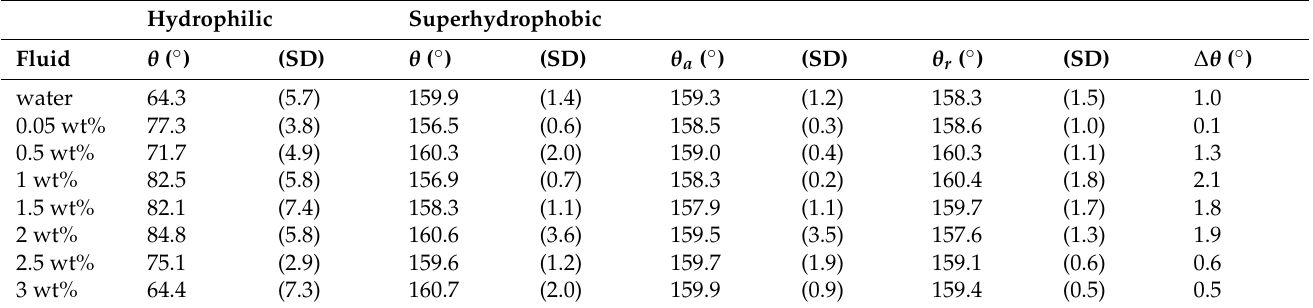
Table 6. Mean contact angles of all working fluids, for the hydrophilic and superhydrophobic regions, before the experimental test, at a temperature of 20 ◦